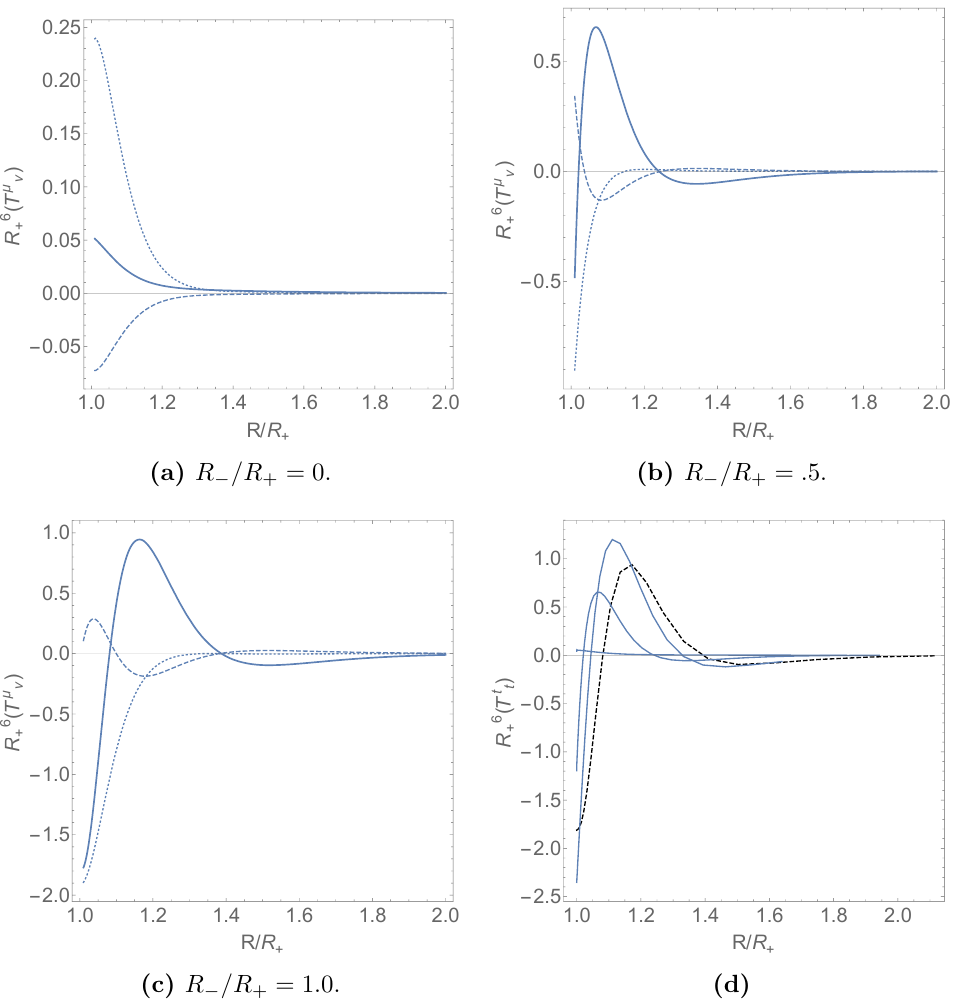
Figure 6. (a){(c) are plots of the six dimensional 8 (cid:25)G 6 of R (cid:0) =R + . In the plots, the thick line is the energy density T t dashed line is T (cid:10) . In (d), we plot the energy densities for R (cid:0) =R + =0, .5, .9, and 1.0 (black, (cid:10) dotted